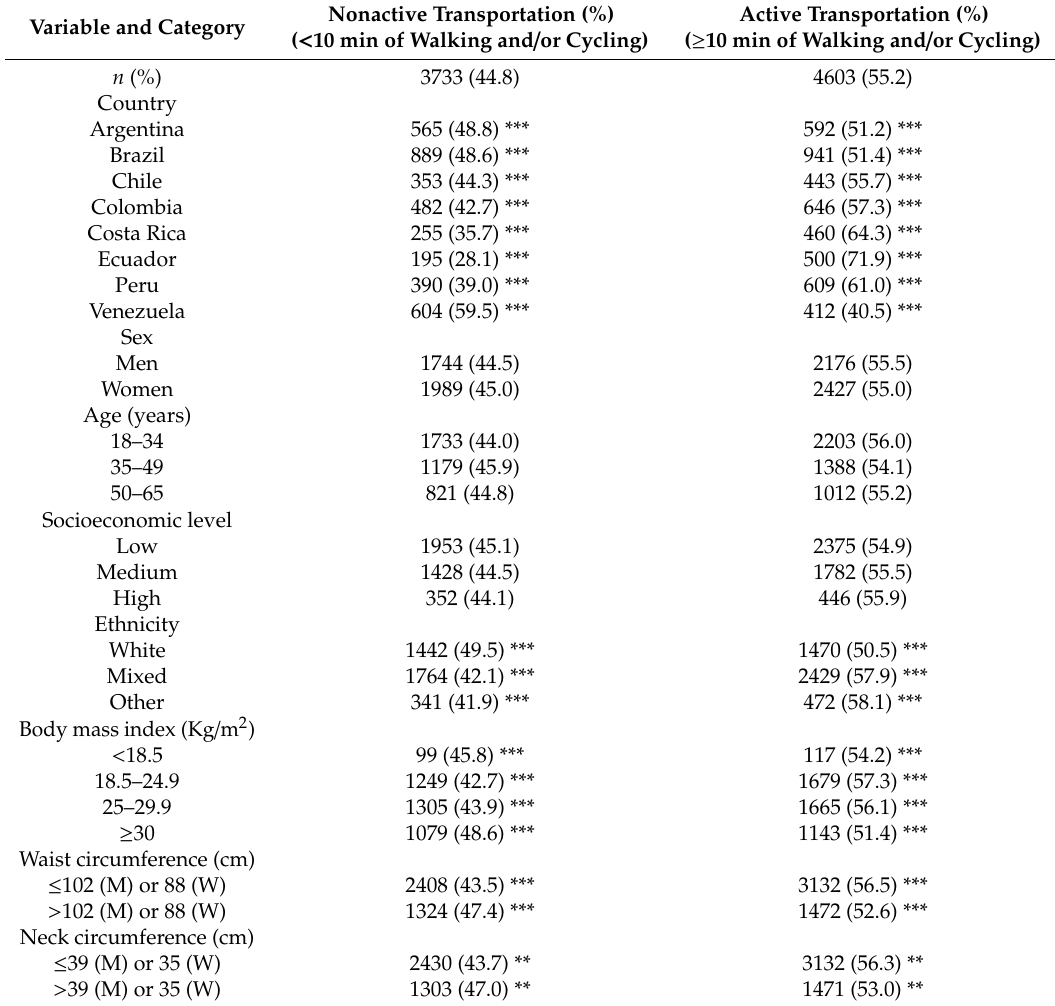
Table 1. Sociodemographic and obesity indicators of the population according to active transportation categories. Variable and Category